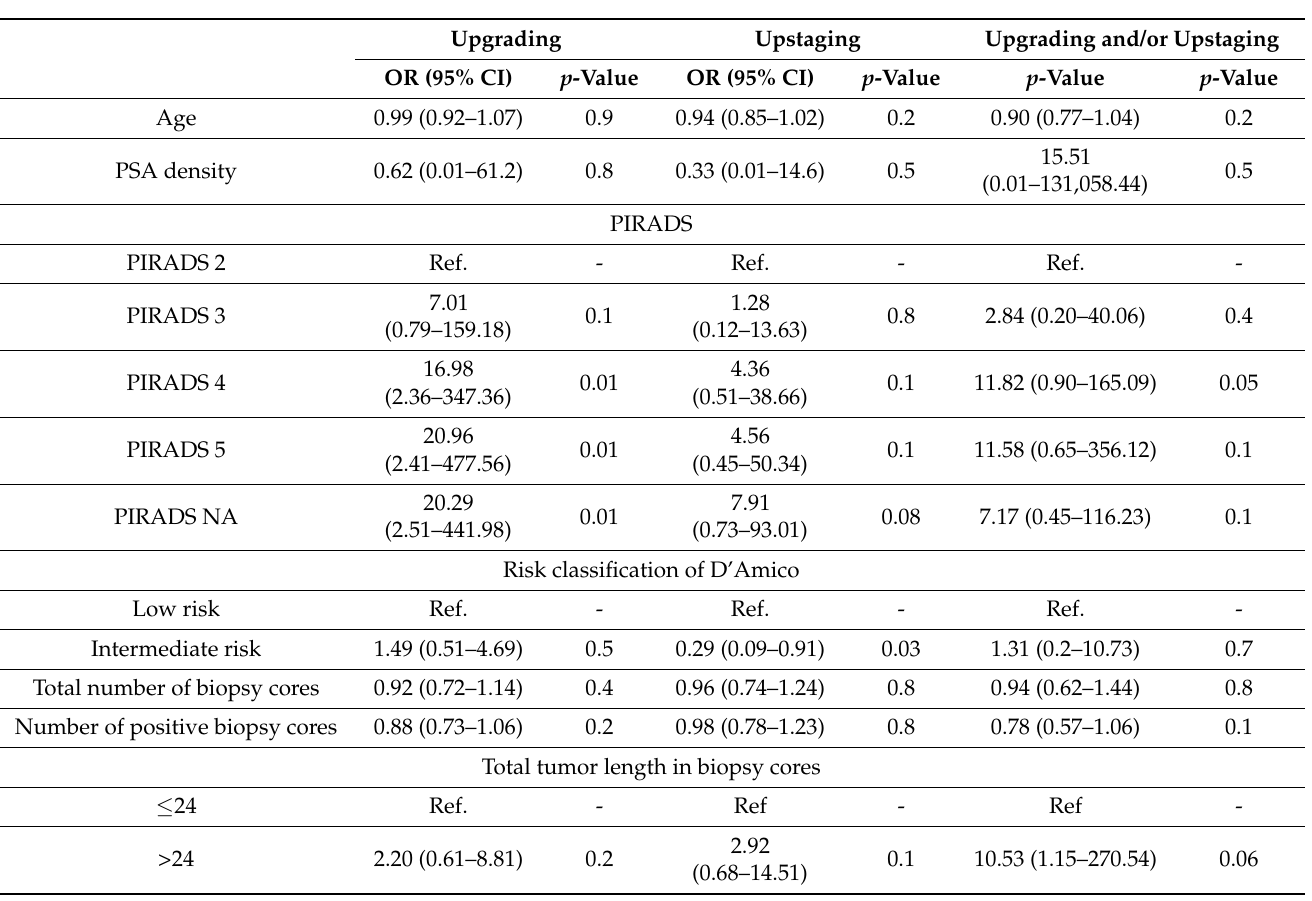
Table 5. Weighted multivariable-adjusted 1 logistic regression analyses predicted the effect of upgrad- ing, upstaging and upgrading and/or upstaging presence within D’Amico risk classification of PCa patients, respectively. Upgrading Upstaging Upgrading and/or